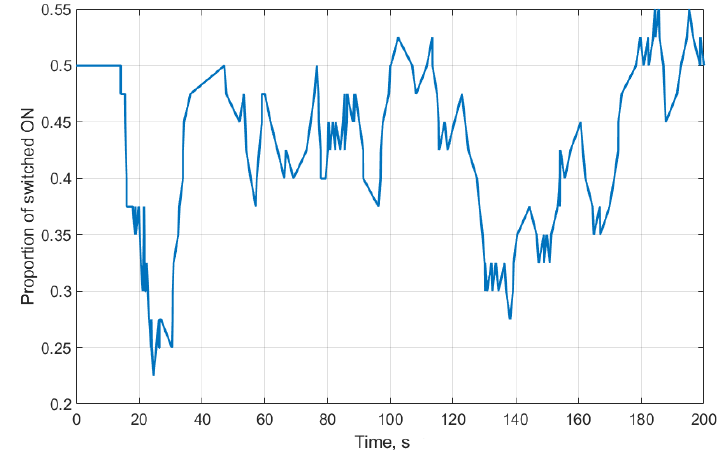
Figure 7. TCLs’ proportion that remain ON in a simulated time interval of 200 s.